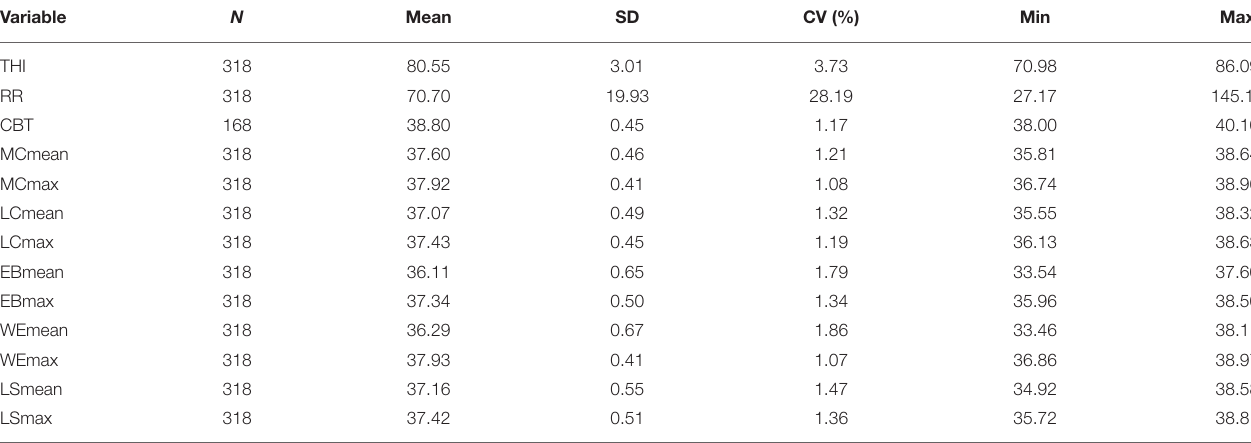
TABLE 1 | Number of observations (N), mean, standard deviation (SD), coefficient of variation (CV), minimum (Min), and maximum (Max) values of meteorological and physiological variables.